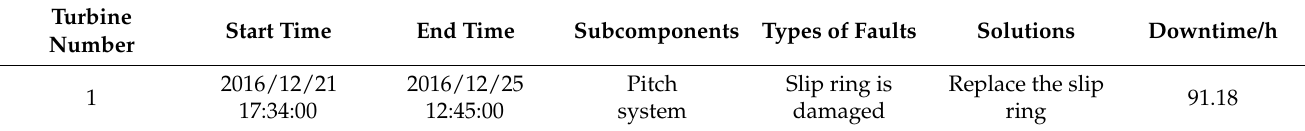
Table 2. An example of a record in maintenance